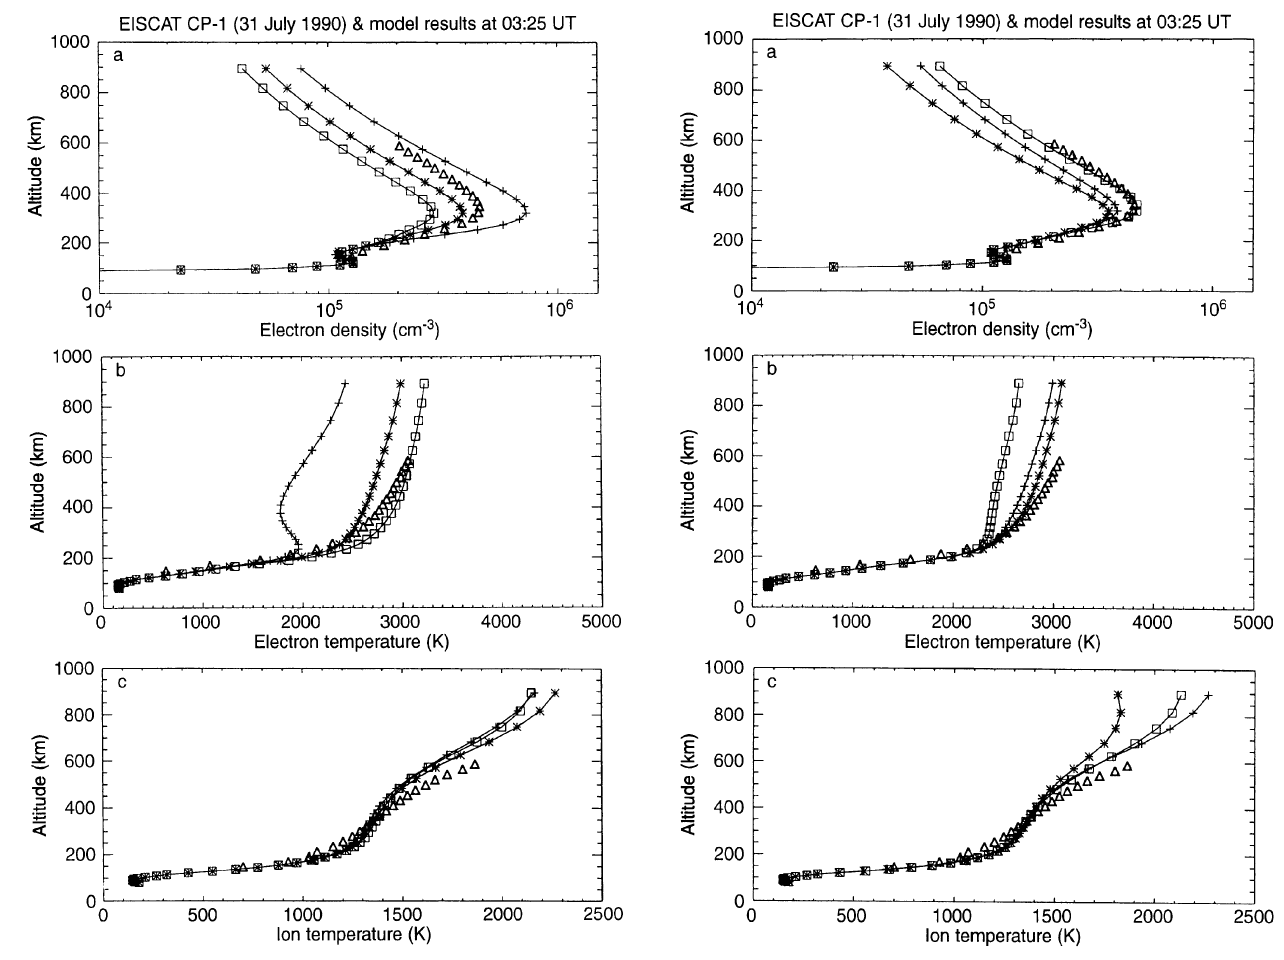
Fig. 3. As in Fig. 2, but illustrating the effect of different convection patterns; maximum FACs in the 06 — 18-MLT meridional plane ( curves with crosses ), 08 — 20 MLT ( asterisks ) and 10 — 22 MLT ( squares